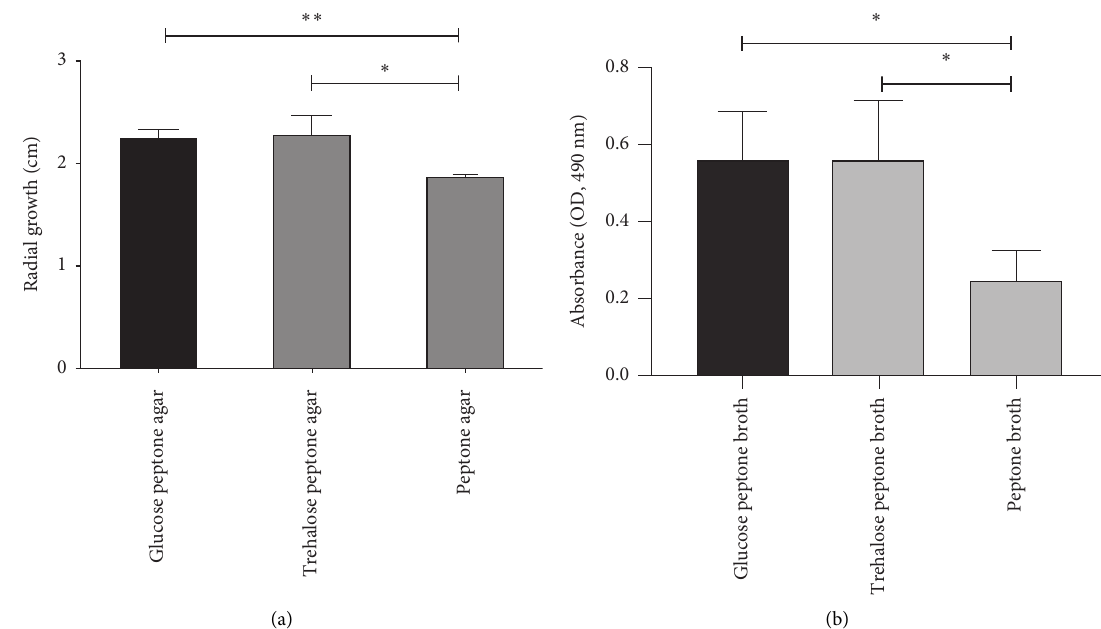
Figure 2: Aspergillus flavus utilizes trehalose as a sole carbon source similar to glucose. (a) Aspergillus flavus ATCC 204304 was incubated at 37 ° C on glucose peptone, trehalose peptone, and peptone alone media. The radial growth of these fungal growths was measured on the second day of incubation. Data are presented as means ± SE from three biological replicates. ∗ P value < 0.05; ∗∗ P value < 0.01 (one-way ANOVA with post hoc Bonferroni’s test). (b) Aspergillus flavus ATCC 204304 was incubated at 37 ° C on glucose peptone, trehalose peptone, and peptone alone liquid media for 24 hours, and viability tests using XTTassays were performed. Data are presented as means ± SE from three biological replicates. ∗ P value < 0.05 (one-way ANOVA with post hoc Bonferroni’s